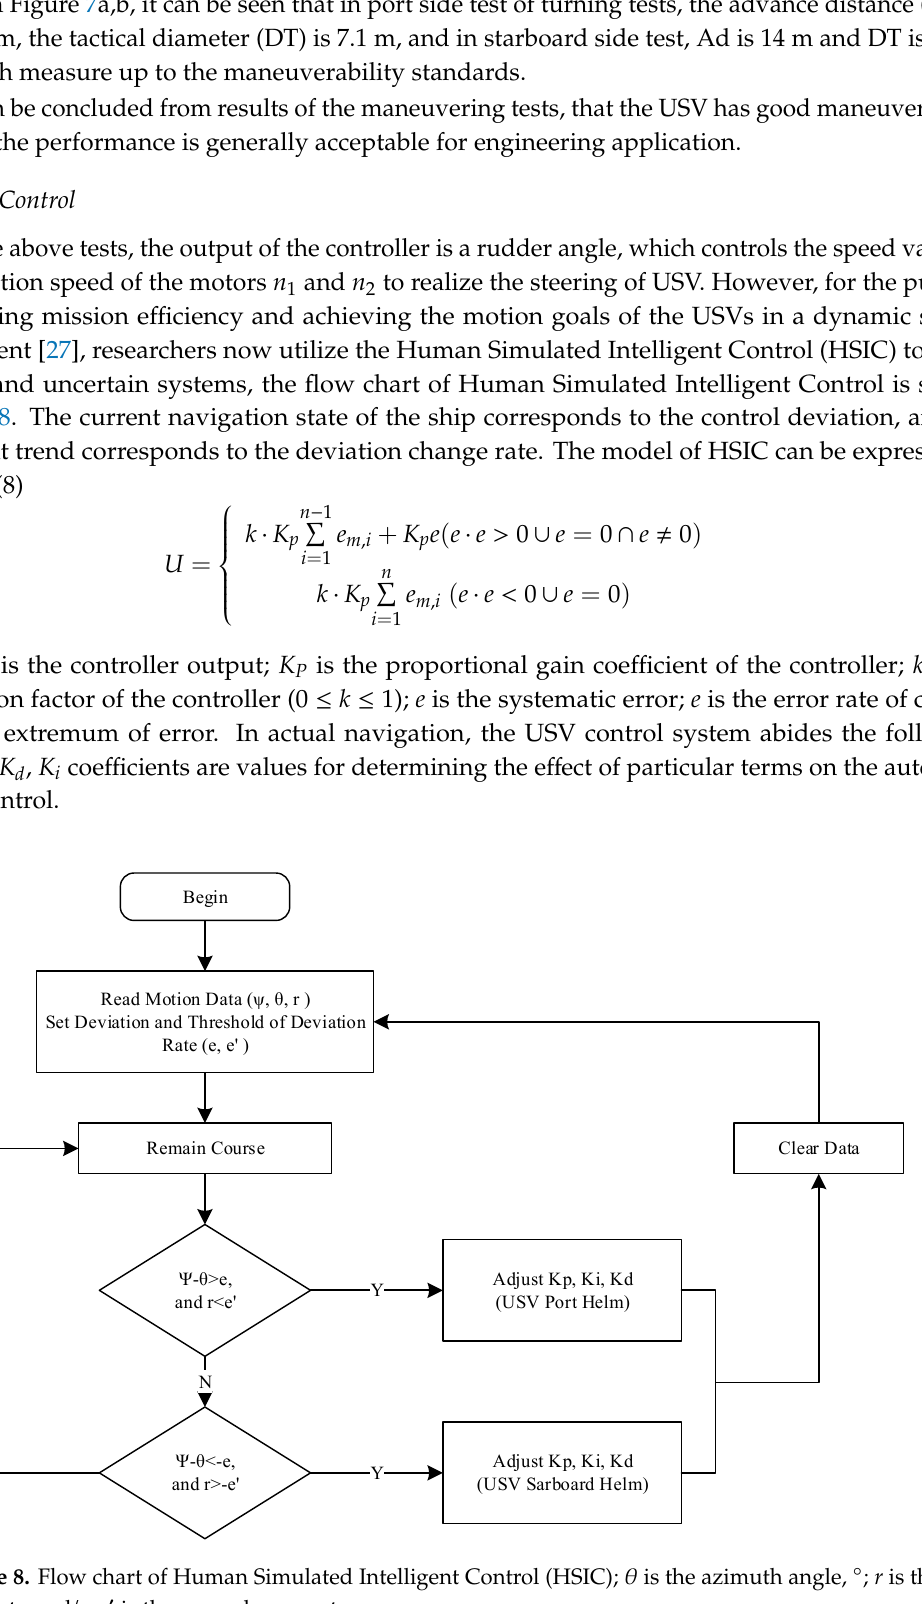
Table 4. Mapping relation of rudder angle and rotation speed n1 and n2. Rudder Angle